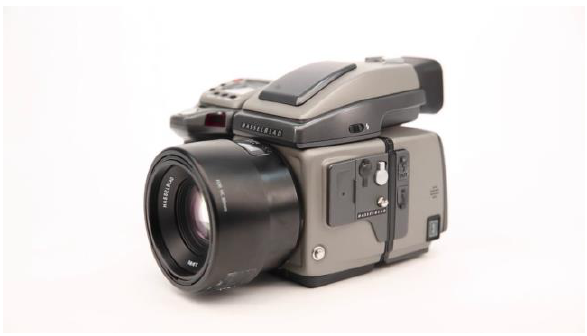
Figure 3. Digital camera HASSELBLAD